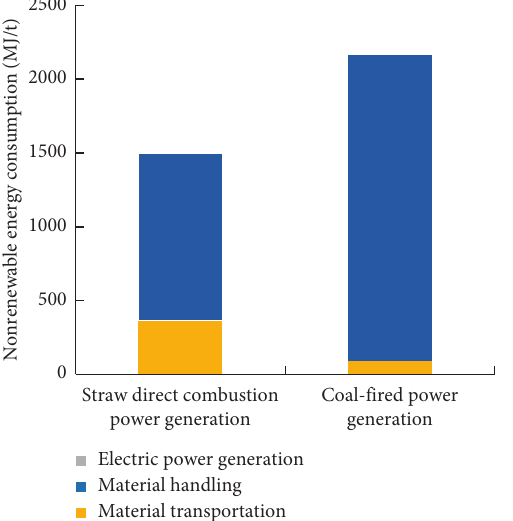
Figure 7: Contribution of different ways of power generation to GWP impact.